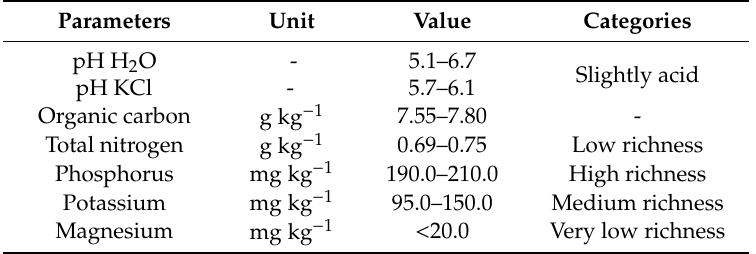
Table 2. Chemical properties of soil at the experimental site before